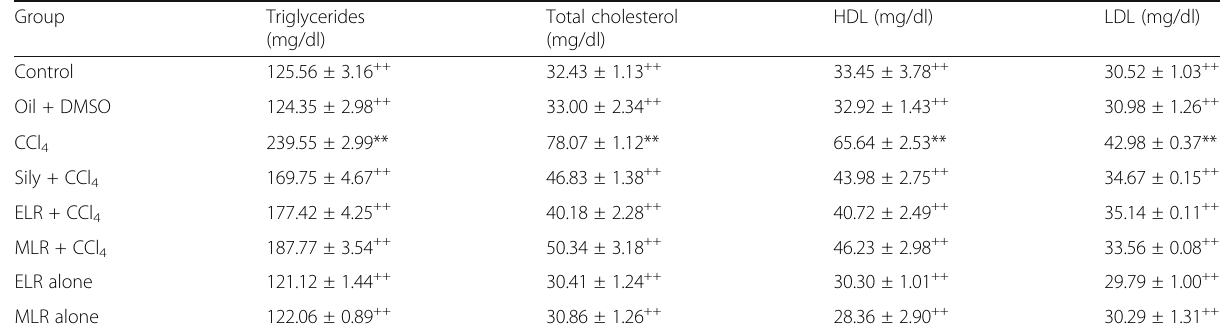
Table 2 Effects of various fractions of R. hastatus leaves on lipid profile Group